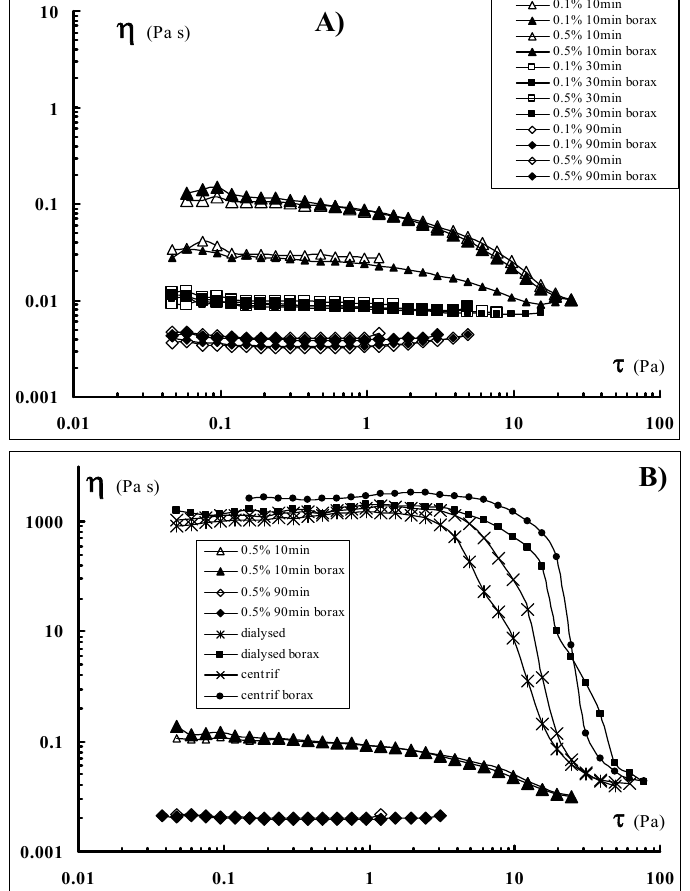
Figure 3. Flow curves of Sclg samples (cp = 0.7%), previously sonicated at cp = 0.1% and cp = 0.5%, with (full symbols) and without borax (empty symbols) (A). Flow curves of Sclg sonicated (cp = 0.5%) for 10 and 90 min with and without borax: for comparison, also the flow curves recorded for the dialysed and the centrifuged Sclgs, are reported (B).